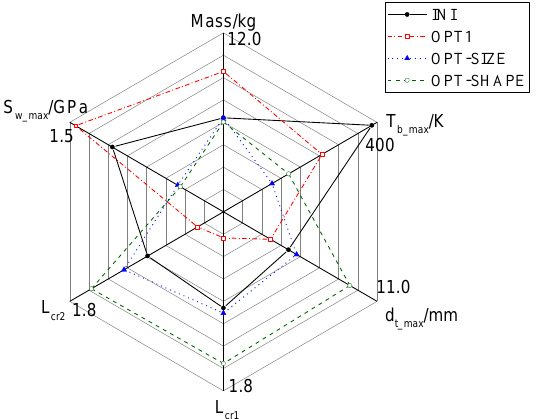
Figure 17. Comparison of the thermal and mechanical responses of the initial and optimized de- signs.